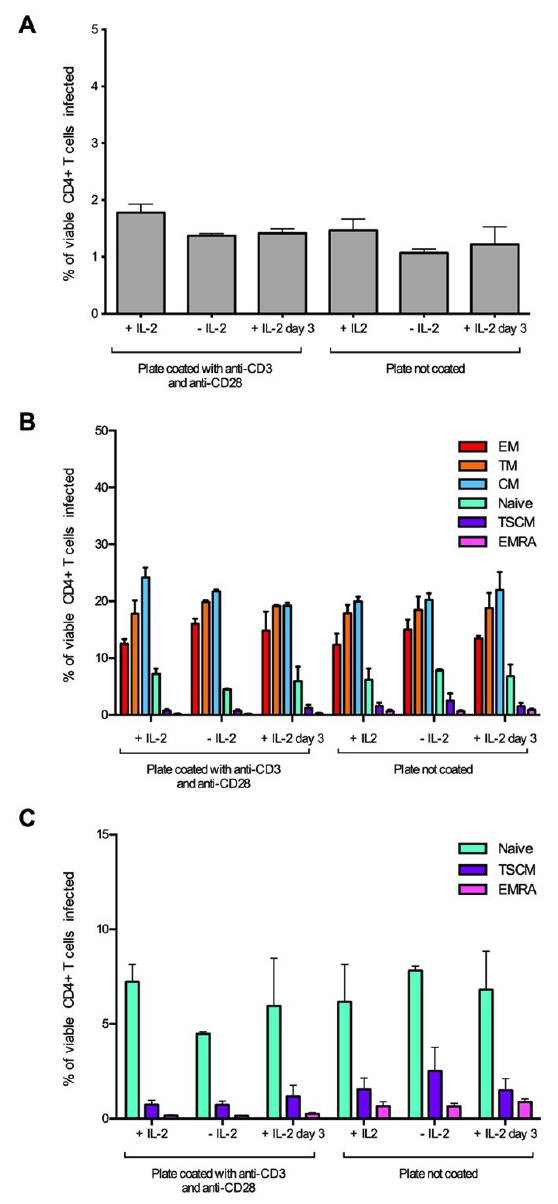
Figure 2. Establishment and optimization of assay conditions for the detection of HIV-1 infected TSCM cells. CD4 + T cells were isolated from two donors and infected with 3,000 IU of JR-CSF Env-pseudotyped GFP reporter virus. Cells were incubated for three days prior to infection on coated (anti-CD3 and anti-CD28, 5 μg/mL) or uncoated wells with and without the addition of IL-2 (20 U/mL) to the culture media. A third condition of the addition of IL-2 post-infection (day 3) was also tested. For all conditions, >1 million events were collected on a LSR Fortessa flow cytometer 3 days post infection. ( A ) There was little change in the level of infection between the assay conditions, although there was a slight reduction in infection in uncoated wells and in wells without IL-2. ( B ) There was little difference in the proportion of CD4 + T cell subset infection between the conditions; however, ( C ) there was a trend for an increased infection of TSCM from uncoated wells. Panel C represents the naïve, TSCM and EMRA T cell subset populations from panel B plotted on a smaller scale. Bar graphs represent the median and